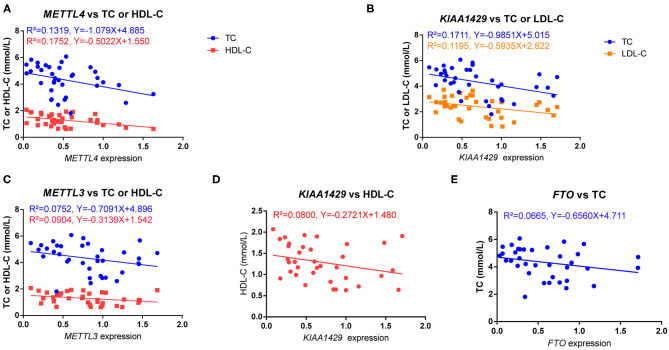
The relationship of m6A regulators with serum lipids. (A) The expression of METTL4 was negatively correlated with TC (r = −0.3632, P = 0.0295) and HDL-C (r = −0.4186, P = 0.0111). (B) The expression of KIAA1429 was negatively correlated with TC (r = −0.4137, P = 0.0121) and LDL-C (r = −0.3457, P = 0.0389). (C–E) The association of METTL3, KIAA1429, and FTO with TC or HDL-C was near the border of significance (P-value range from 0.05 to 0.1). The relation was determined by Pearson correlation test.